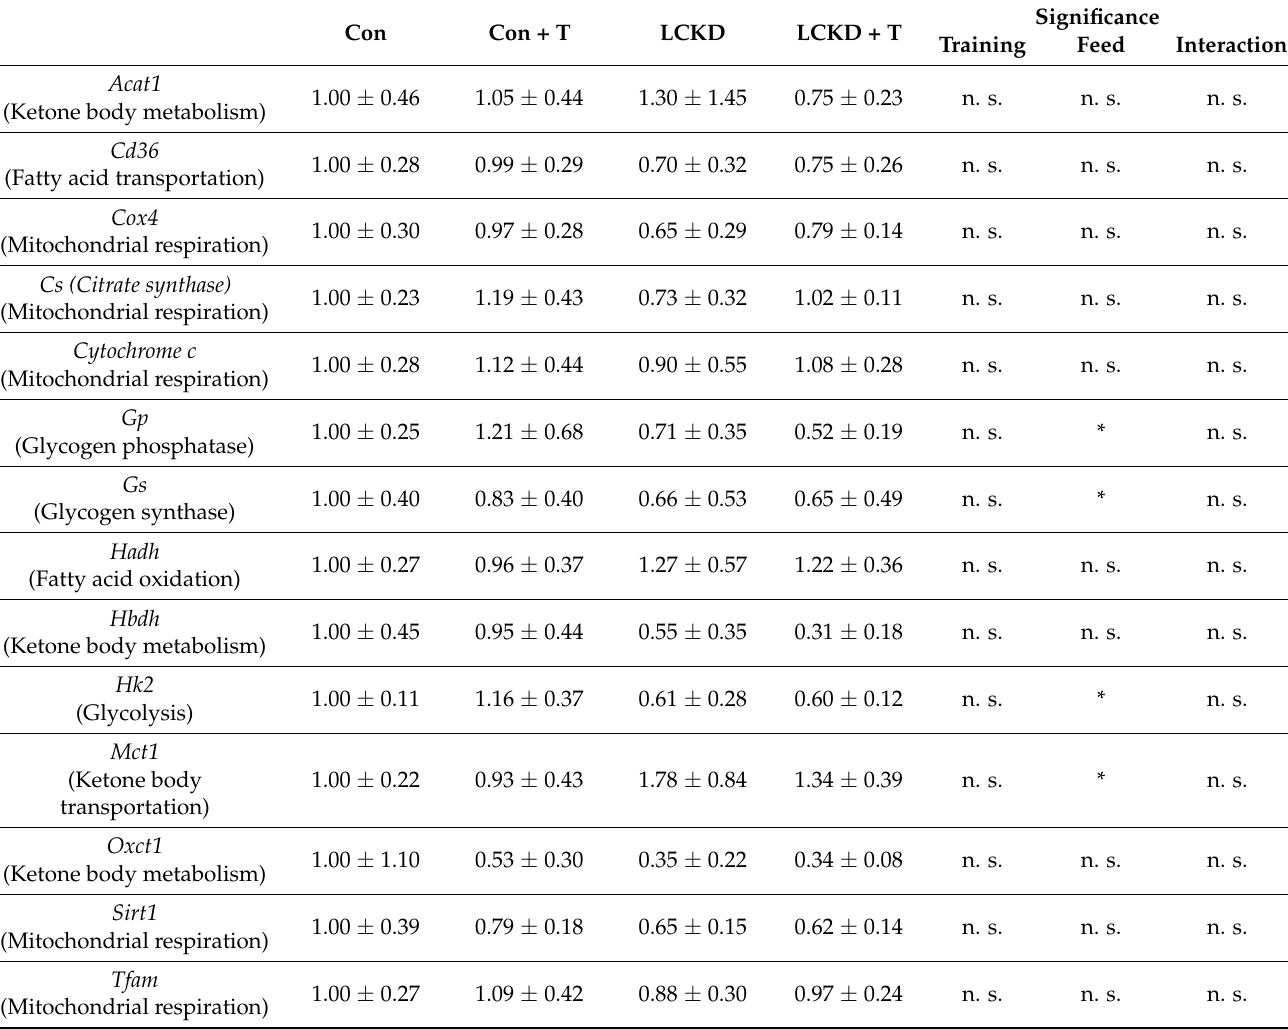
Table 9. The effect of LCKD feeding and/or training on gastrocnemius muscle gene